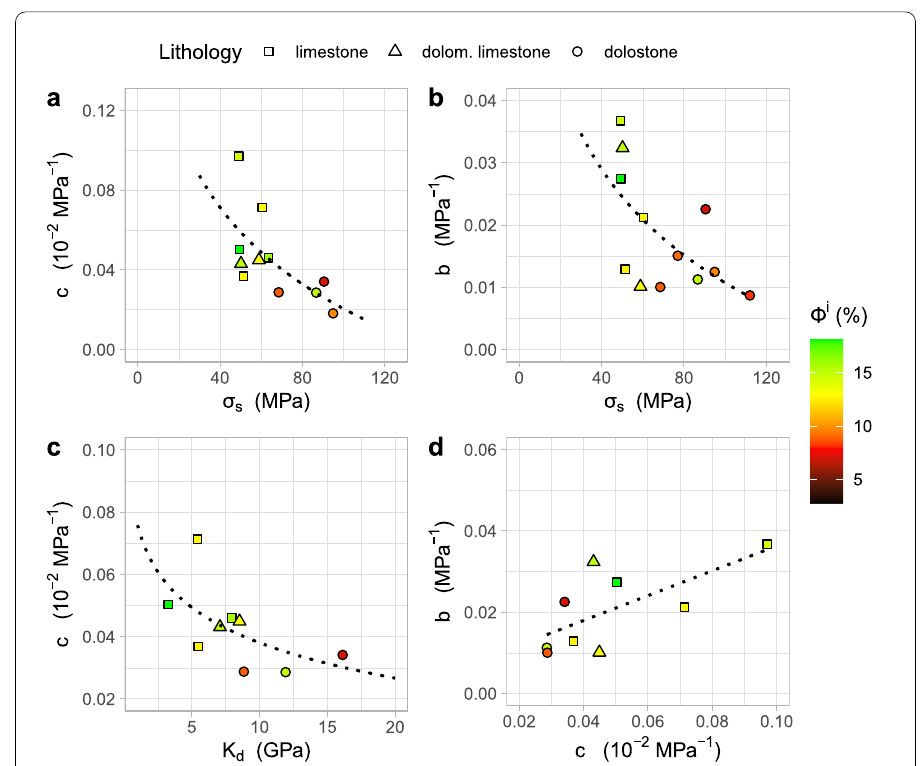
Fig. 11 Correlation of stress sensitivity coefficients with characteristic rock parameters. a Stress sensitivity coefficient for porosity c decreases with increasing rock strength σ s . Samples with higher initial porosity Φ i are mostly more stress sensitive than those with lower Φ i . b Correlation between the stress sensitivity coefficient for permeability b also indicates a decreasing sensitivity with increasing σ s , but is fuzzier than for porosity. Most samples with low initial porosity Φ i also shows a low stress sensitivity of permeability. c Relationship of c with the drained bulk modulus K d indicates a decreasing stress sensitivity with decreasing compressibility of the porous medium. d Stress sensitivity of permeability increases with increasing stress sensitivity of porosity. High values for b compared to c indicate a decoupling of the permeability dependence from the porosity and an increasing contribution of cracks or fractures to the flow